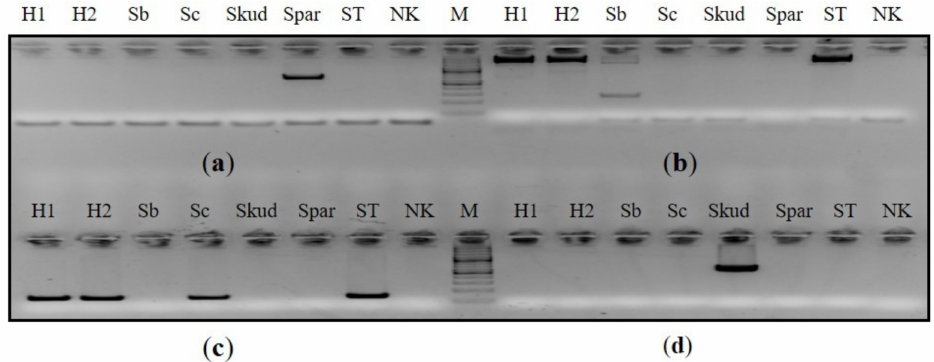
Figure 1. The results of species-specific PCR: ( a ) amplification with SparF7 and SparR7 primers, specific for S. paradoxus ; ( b ) amplification with SbayF1 and SbayR1 primers, specific for S. bayanus ; ( c ) amplification with ScerF2 and ScerR2 primers, specific for S. cerevisiae ; ( d ) amplification with SkudF2 and SkudR1 primers, specific for S . kudriavzevii . H1, H2: isolates investigated, Sb: S. bayanus DBVPG 8001, Sc: S. cerevisiae CBS 1171, Skud: S. kudriavzevii CBS 8840, Spar: S. paradoxus CBS 432, ST: Fermol Elegance S. cerevisiae starter strain, NC: negative control containing water instead of DNA, M: molecular weight standard, Gene ruler 100 bp (ThermoFisher Scientific, Waltham, MA, USA). The figure was constructed based on different photos of the electrophoresis.